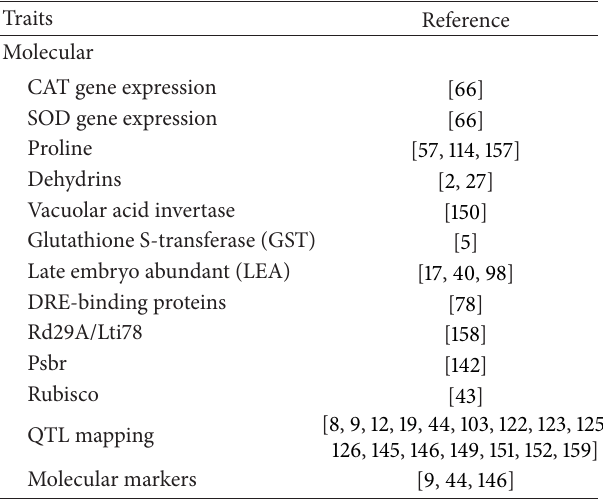
Table 4: Research scenario of molecular traits under drought stress in wheat.